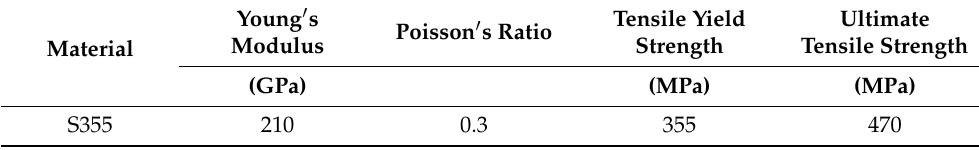
Table 3. Mechanical properties of the spike segment material.